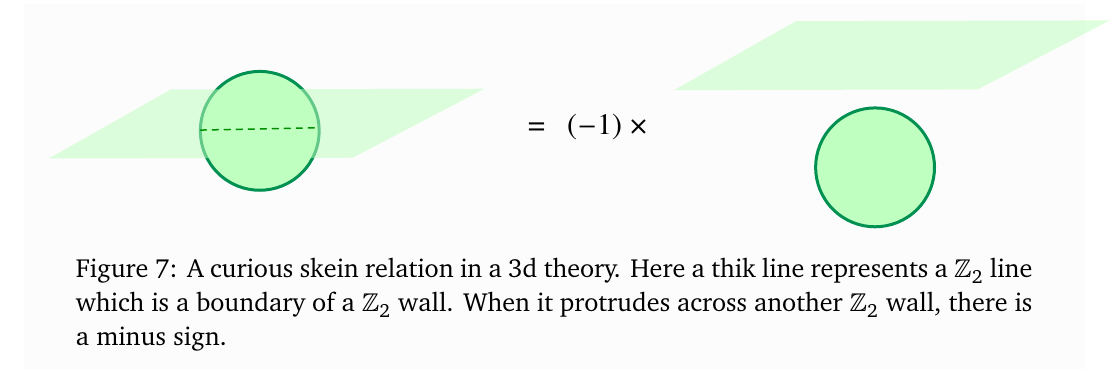
wall. When it protrudes across another (cid:90) 2